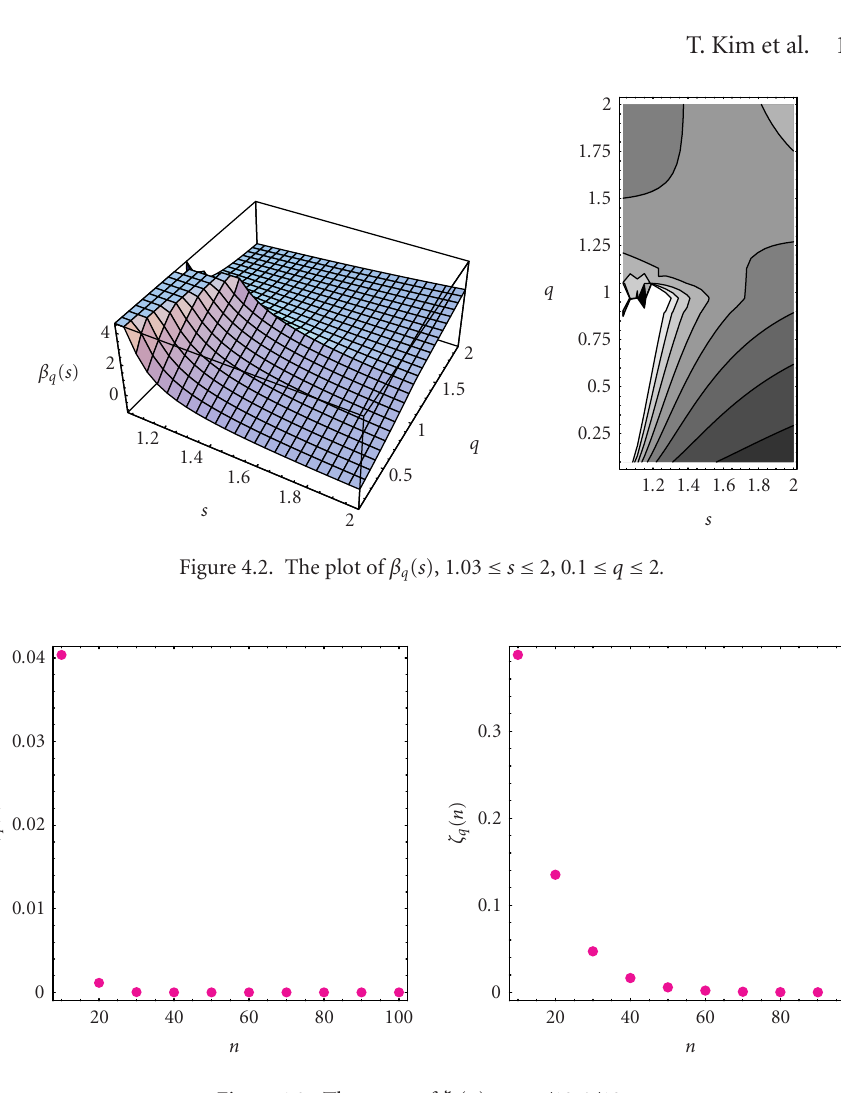
Figure 4.3. The curve of ζ q ( n ), q = 7 / 10,9 / 10 .